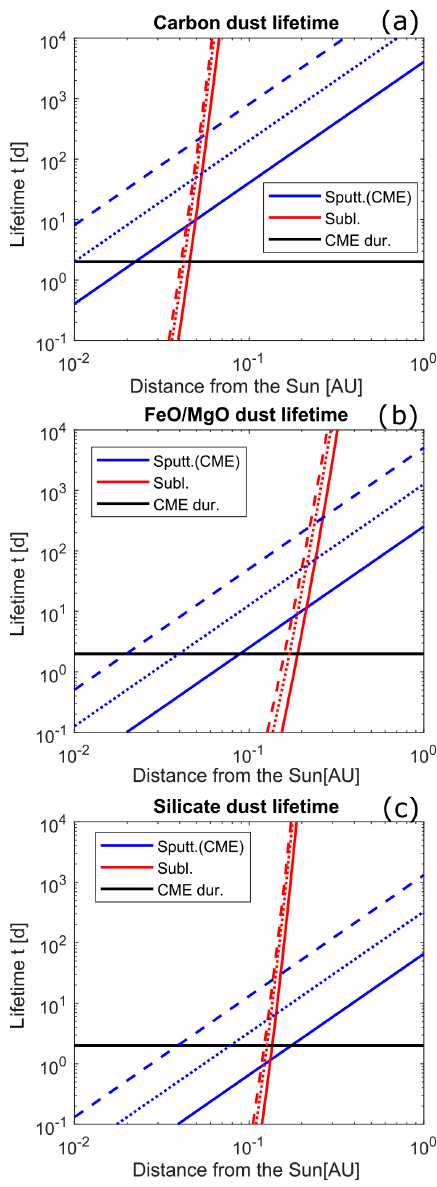
Figure 9. Comparison of sputtering and sublimation lifetimes of nanometre-sized dust near the Sun. Blue lines indicate sputtering lifetimes, red lines indicate sublimation lifetimes, line style indi- cates dust size (dotted – 5nm, solid – 1nm, dashed – 0.2nm), and the 2d duration of a typical CME is in